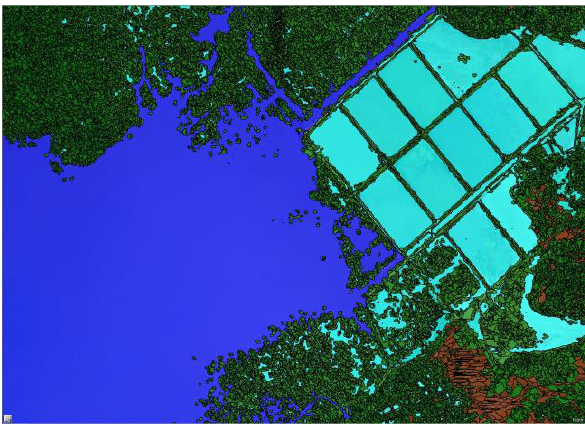
Figure 11c. Image showing extracting the sea. Despite the extraction of sea, there were still Water segments which did not belong to the aquaculture ponds (see smaller Water segments of Fig. 11c). Water segments with number of pixels small than 20,000 were reclassified to Vegetation (see Fig. 11s), which left the remaining segments classified as Water to be those of the aquaculture ponds.